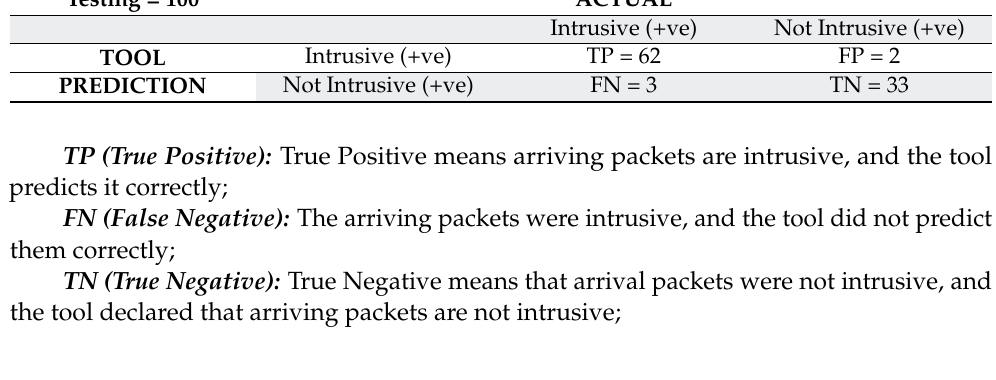
Figure 14. Account Block in case of invalid queries.